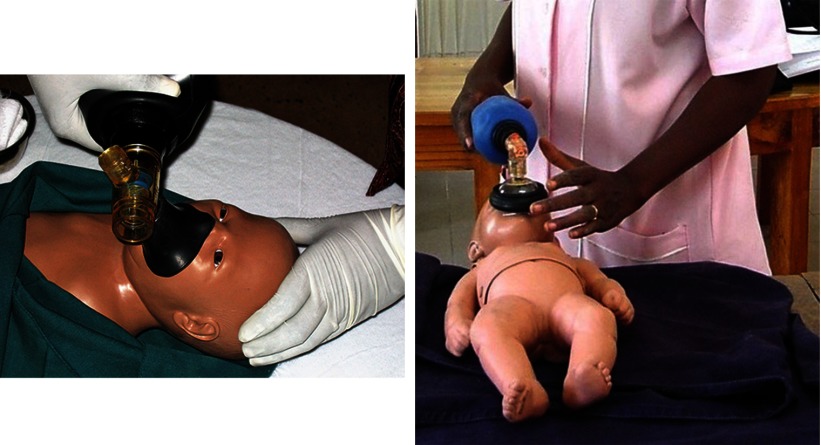
Neonatal Resuscitation With an Ambu Bag: Correct vs. Incorrect PositioningLeft: Correct positioning of mask, bag, and newborn's head to achieve a good seal, with bag perpendicular to the newborn's body. © 2006 Steven Harvey.Right: Incorrect positioning, with bag parallel with the newborn's body, making it more difficult to achieve a good seal. © 2002 Steven Harvey.